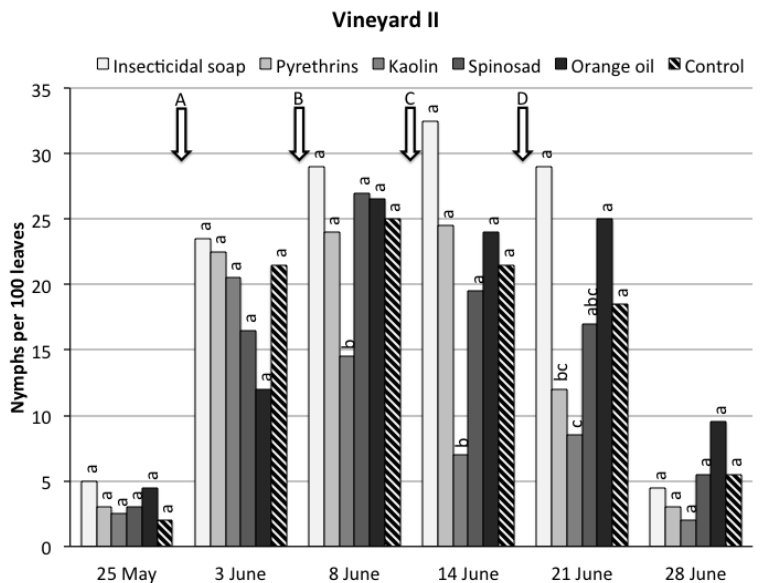
Figure 2. Scaphoideus titanus nymphs recorded on grapevine suckers during the sampling period in vineyard II under six different treatments. Within the same date, different small letters above bars indicate significant differences according to t -tests on the least square means with Bonferroni correction (α = 0.05). The arrows indicate the application timings of the natural products.